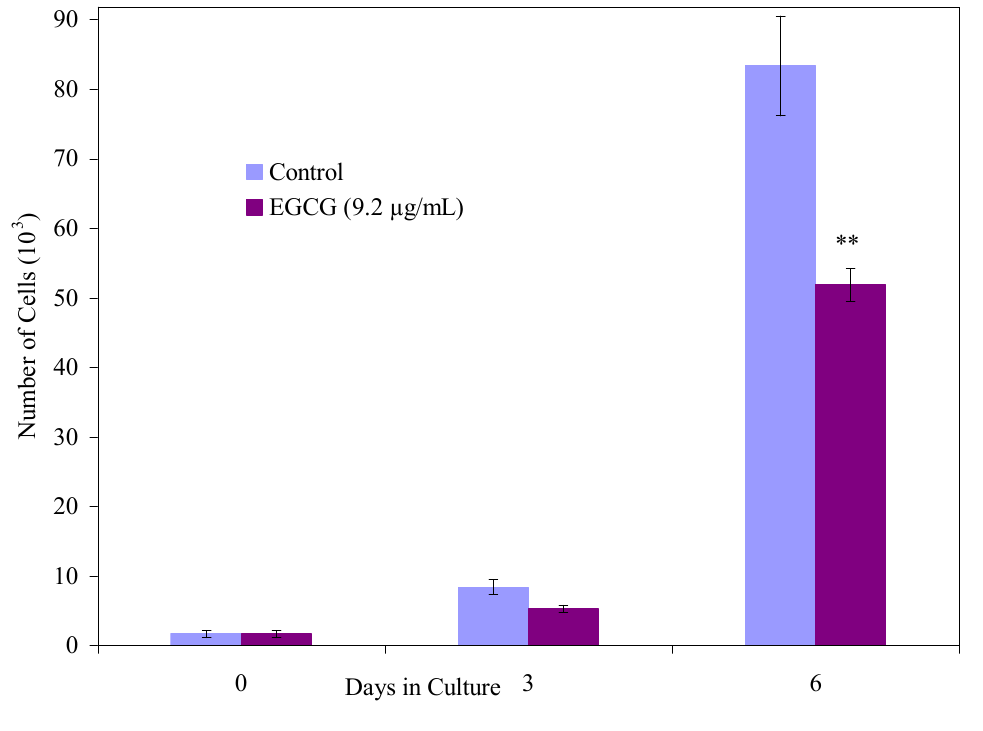
Figure 6. Effect of EGCG on the growth of normal